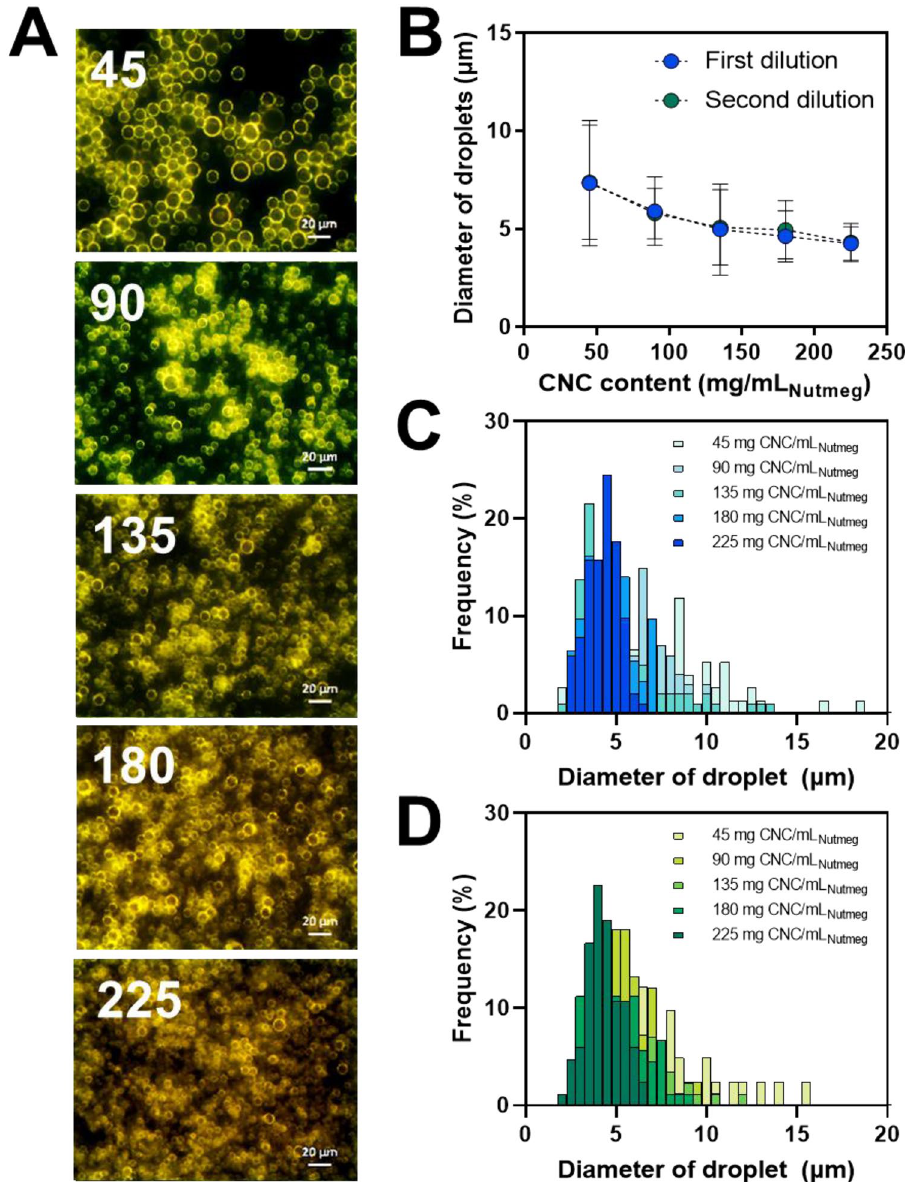
Figure 4. CNC/nutmeg PEs at different CNC contents. ( A ) Dark-field microscopic images of PE, ( B ) size of emulsion droplets and ( C , D ) size distribution of emulsion droplets. ( C ) First dilution and ( D ) second dilution. N = 300, error bar =